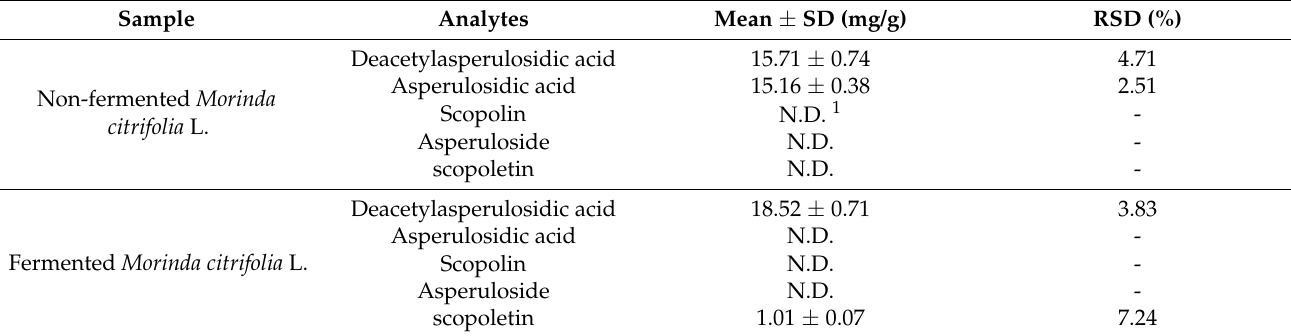
Table 3. HPLC-PDA determination of bioactive compounds in non-fermented and fermented Morinda citrifolia L. extracts. Sample Analytes RSD (%)